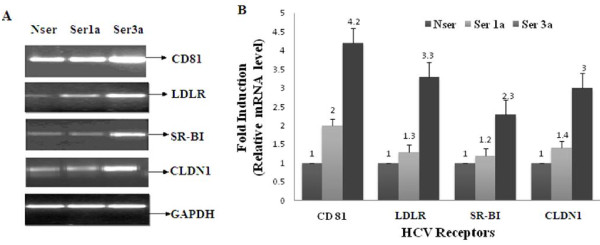
Comparison of expression of CD81, LDLR, SR-BI and CLDN genes in HCV 3a and HCV 1a serum-infected Huh-7 cells. A) Gene expression of CD81, LDLR, SR-BI and CLDN1genes in Huh-7 infected with HCV serum of genotype 3a (S3a) and HCV serum of genotype 1a (S1a) as compared to normal serum (NSer). Cells were harvested and relative RNA determinations were carried out using semi-quantitative PCR. B) Relative gene expression of CD81, LDLR, SR-BI and CLDN1genes in Huh-7 infected with HCV serum of genotype 3a (S3a) and HCV serum of genotype 1a (S1a) as compared to normal serum (N) by real time PCR. All experiments were performed three times independently with triplicate samples in each. Error bars indicate the mean plus or minus SD. *p < 0.01 vs. normal